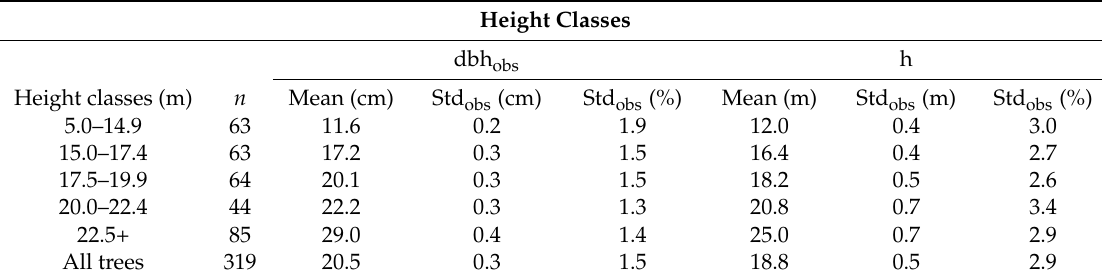
Table 7. The mean dbh obs (mean of cross measurements) and h (height) of five tree size classes that are based on tree height, as well as the class-wise means of standard deviations (std obs ) calculated from the four measurements of dbh obs and